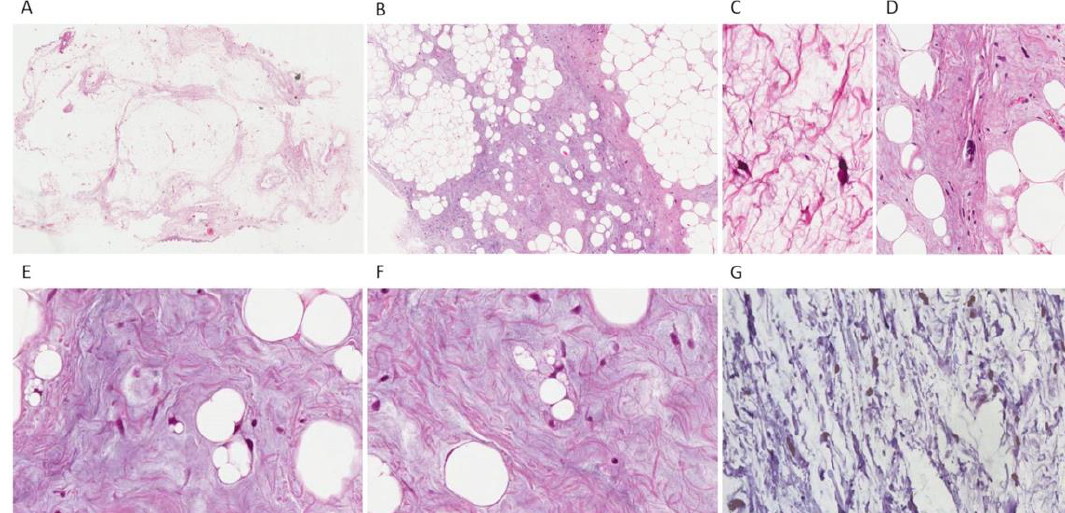
Figure 2. Pathological findings. Histopathologic examination: ( A ) a lobulated lesion composed of mature fat; ( B ) variably sized adipocytes set in fibrous/fibromyxoid stroma; ( C , D ) atypical cells with enlarged, hyperchromatic nuclei in fibro-myxoid septa; ( E , F ) multivacuolated lipoblasts with atypical nuclei. ( G ) Immunohistochemical analysis showed nuclear positivity for MDM2 in neoplastic cells.